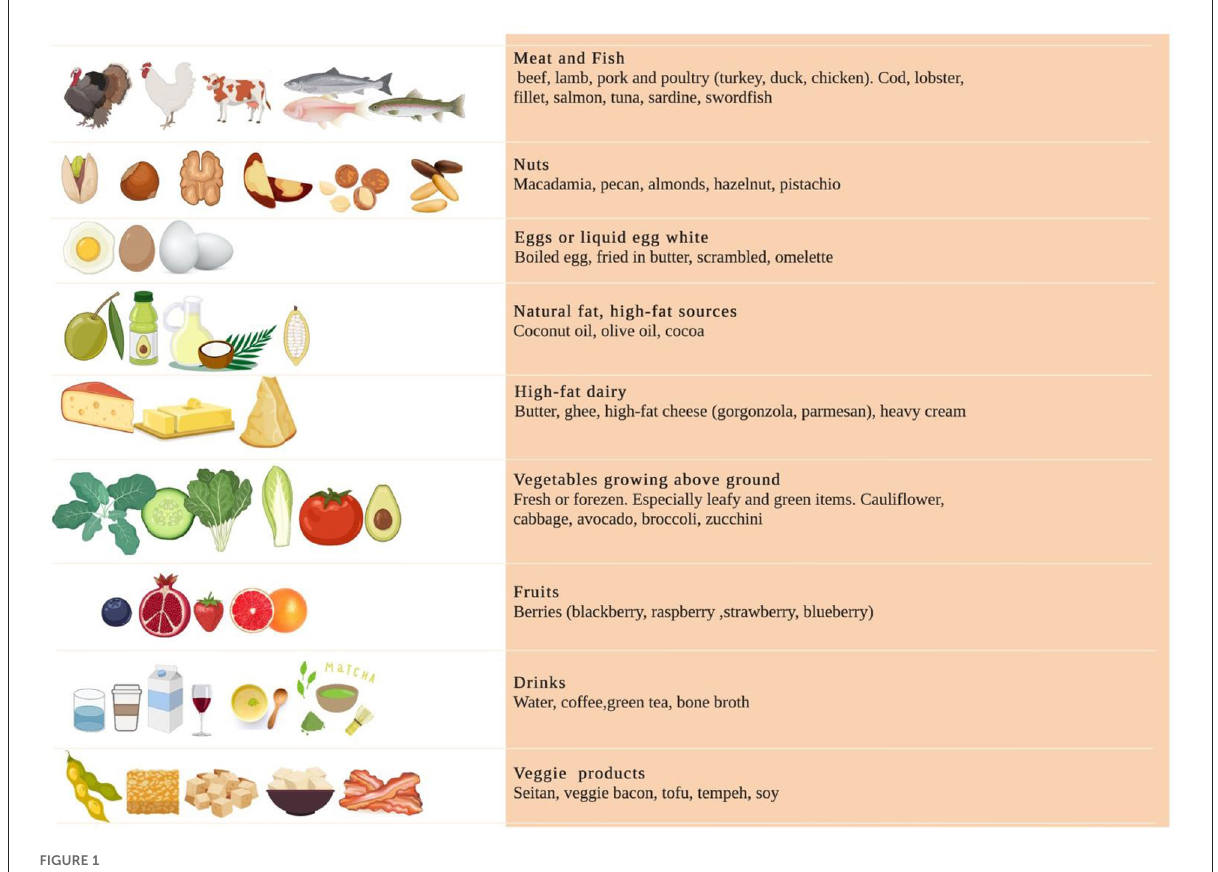
FIGURE1 Detailed list of food